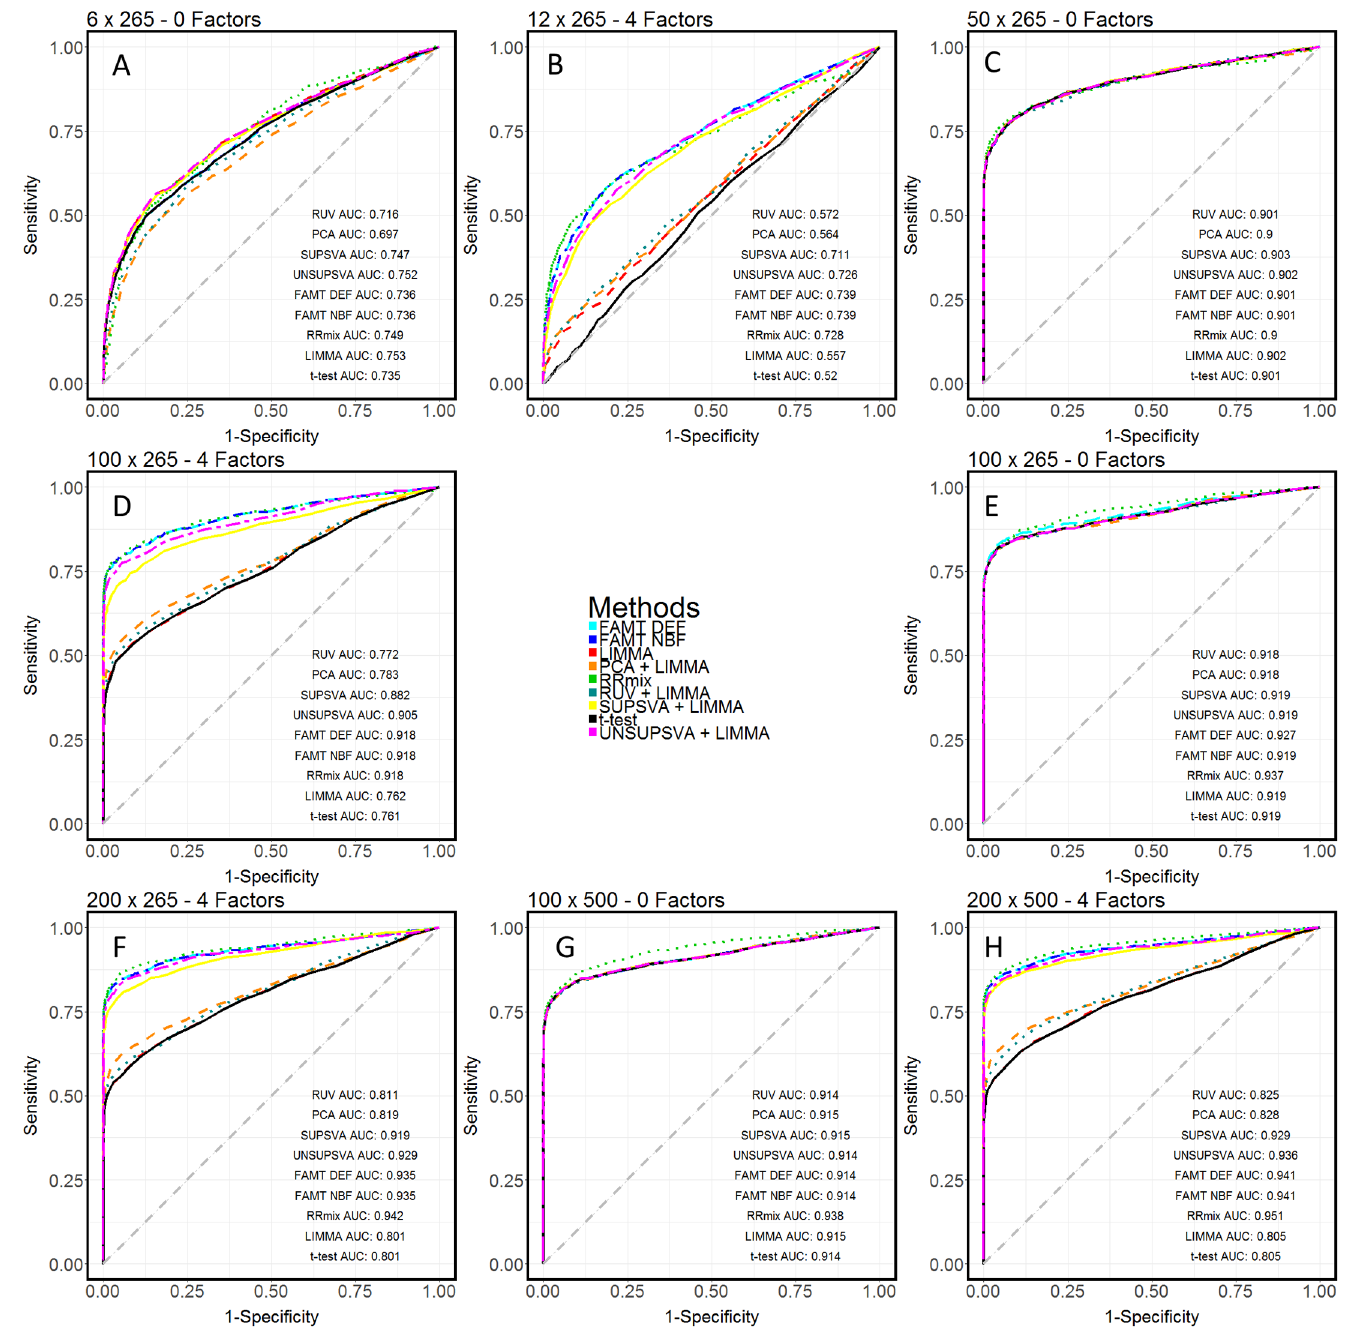
Fig 3. Evaluation of model performance using ROC of